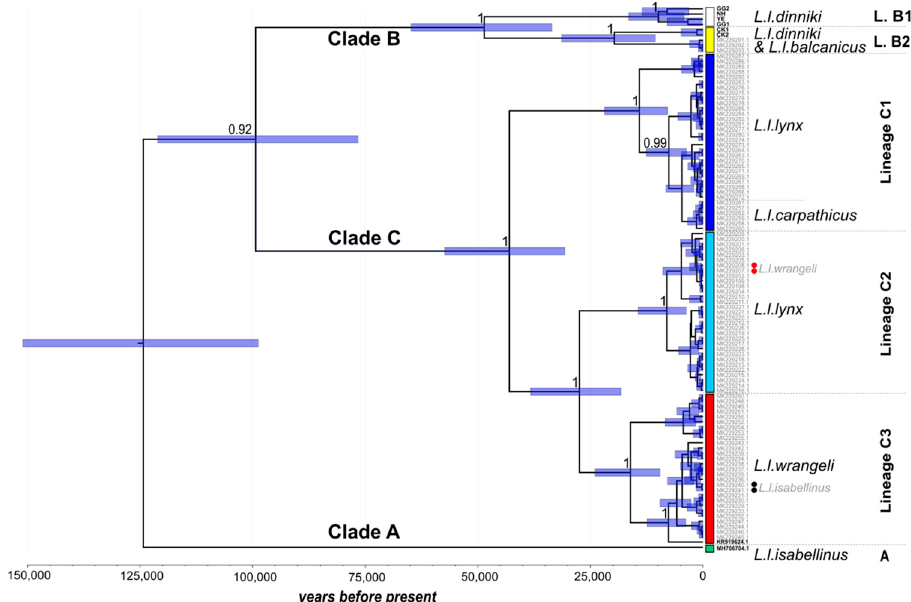
Figure 2. Bayesian phylogenetic tree of L. lynx mitogenome sequences. Posterior node support is given for all nodes with values >0.9. Blue bars at nodes indicate the 95% credibility intervals for coalescence times in years ( x -axis). The three main branches are labeled according to clade assignment; lineage and subspecies assignment is indicated on the right. Vertical colored bars mark lineages, which are separated by dashed horizontal lines. Sequences are labeled by either GenBank accession number [18,38,47] or by location ( L. l. dinniki ). Red dots mark two L. l. wrangeli individuals within lineage C2 (see text for explanation); black dots indicate the two erroneously labeled L. l.